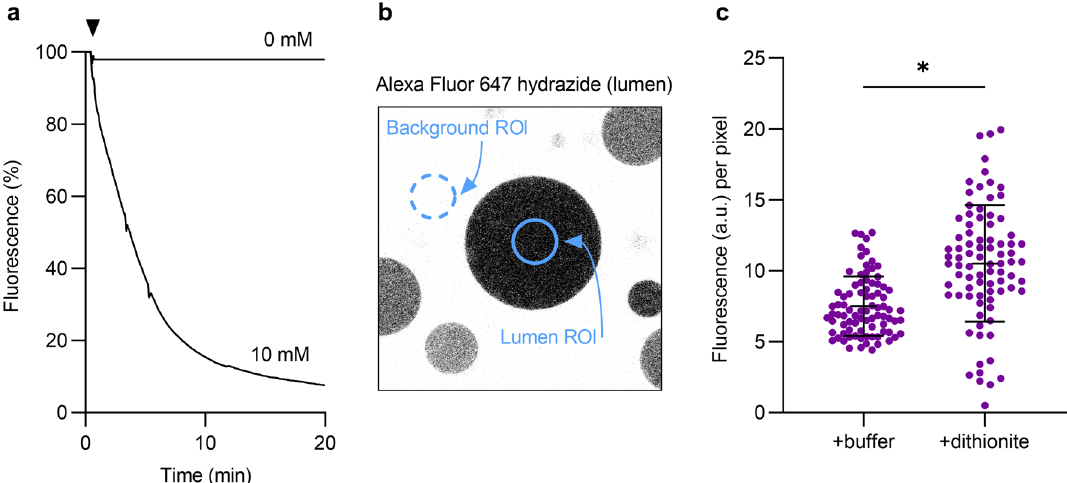
Figure 5. Dithionite does not permeate across the membrane of pGUVs. ( a ) Fluorescence time trace of 10 µM Alexa Fluor 647 hydrazide in 250 mM sucrose solution upon addition of 10 mM dithionite. A buffer control (0 mM dithionite) is shown for comparison. The arrowhead indicates dithionite or buffer addition. ( b ) Confocal image of pGUVs with trapped Alexa Fluor 647 hydrazide. A region of interest (ROI) was placed within the GUV for fluorescence quantification, from which the mean of four background ROIs was subtracted. ( c ) Dot plot of Alexa Fluor 647 hydrazide fluorescence of individual pGUVs 12 min after buffer or dithionite addition (n = 84). Black lines indicate mean ± s.d. (unpaired t test with Welch’s correction, *P <